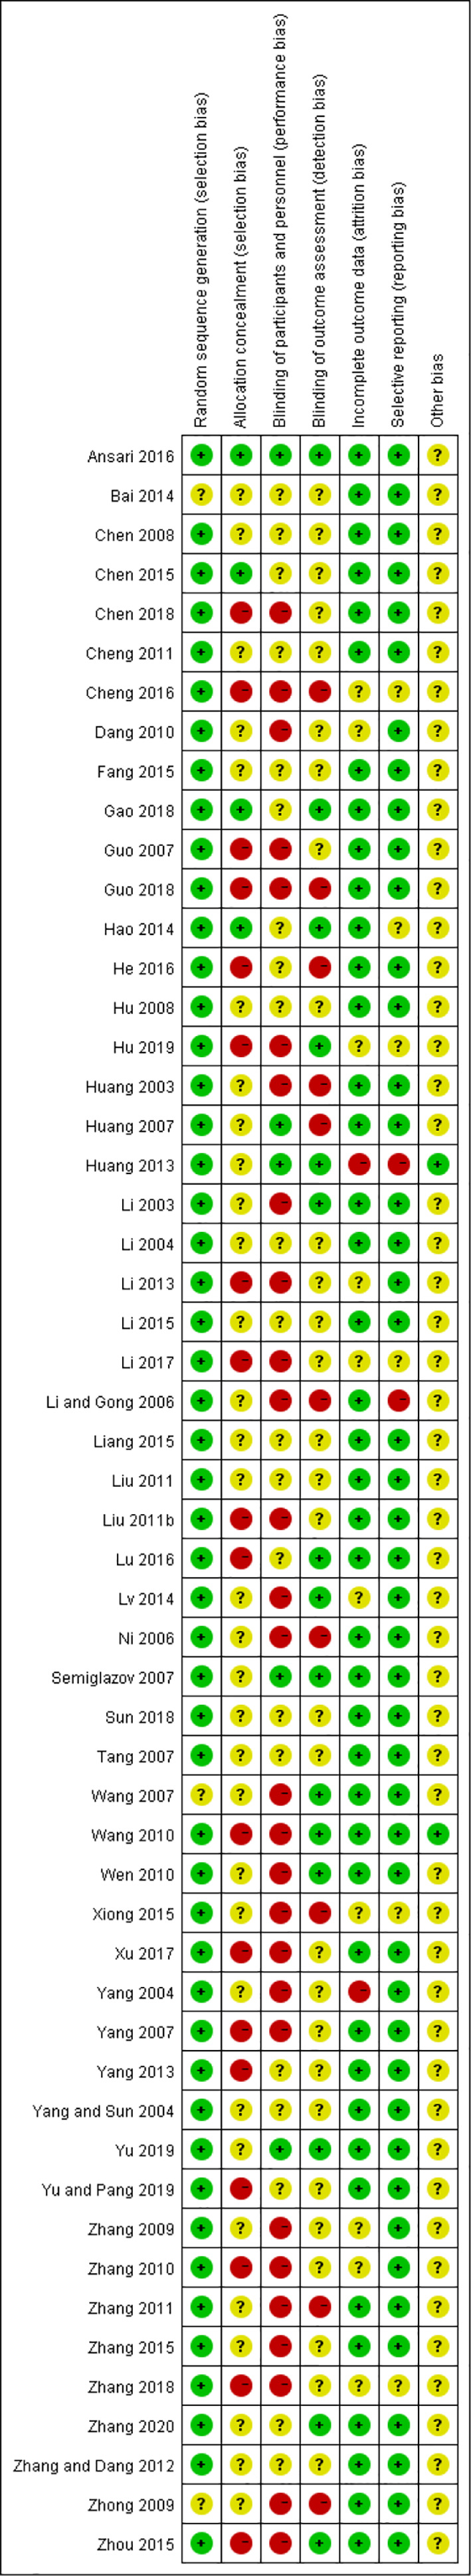
Risk of bias summary.